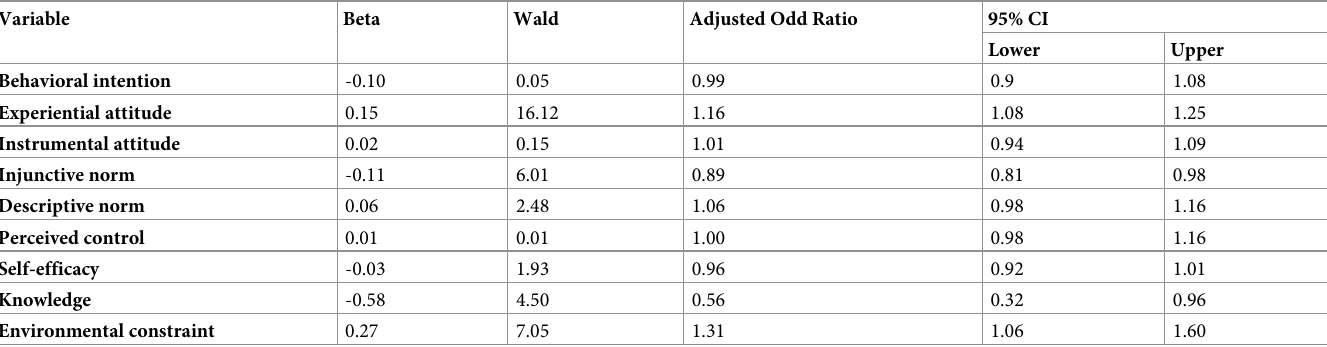
Table 4. Predictors of binge drinking among